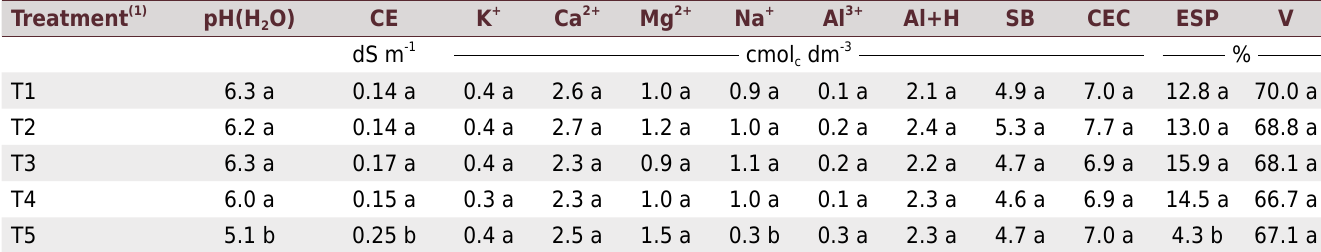
Table 2. Soil chemistry for the 0.00-0.40 m layer after the experiment Treatment (1)